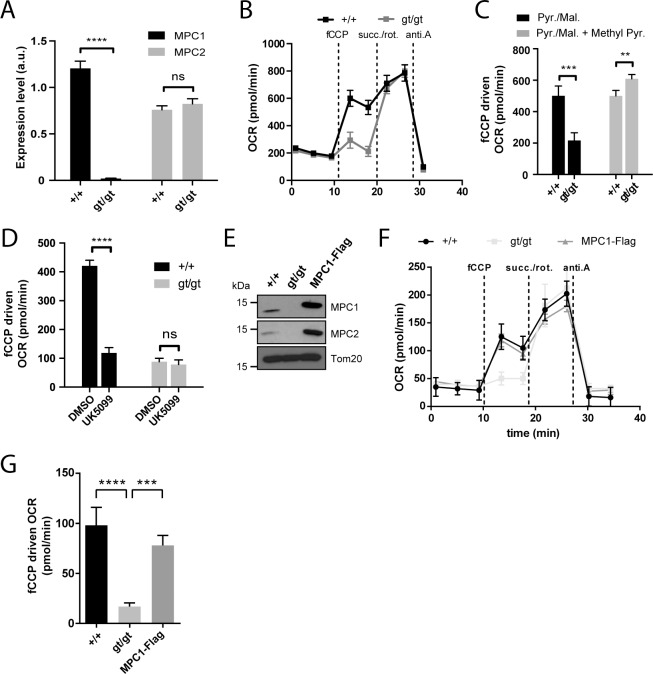
MPC1 is necessary for pyruvate-driven respiration.(A) MPC1 (black bars) and MPC2 (grey bars) mRNA expression level (normalized to 28S rRNA) were evaluated by RT-qPCR in MPC1+/+ and MPC1gt/gt MEFs. ****p<0.0001 (two-way ANOVA). (B) Representative profiles of oxygen consumption rates (OCR) of XF PMP permeabilized primary MEFs with pyruvate/malate provided as carbon sources. fCCP: carbonyl cyanide-4-(trifluoromethoxy)phenylhydrazone; succ.: succinate; rot.: rotenone; anti.A: antimycin A. (C,D) fCCP-driven OCR of MPC1+/+ and MPC1gt/gt permeabilized primary MEFs in the presence of pyruvate/malate (Pyr./Mal.) as carbon sources, and supplemented as indicated with membrane permeable methyl pyruvate (Methyl Pyr.)(C) or with the MPC inhibitor UK5099 or vehicle alone (DMSO)(D). ** p<0.01; ***p<0.001; ****p<0.0001 (two-way ANOVA). (E) Western blot analysis of MPC1+/+, MPC1gt/gt and MPC1gt/gt MEFs stably expressing MPC1-Flag, using antibodies directed against MPC1, MPC2 and Tom20. (F) Representative OCR profiles of immortalized, permeabilized MEFs (MPC1+/+, MPC1gt/gt and MPC1-Flag rescue cells) with pyruvate/malate provided as carbon sources. (G) fCCP-driven OCR from (F); ***p<0.001 ****p<0.0001 (one-way ANOVA).